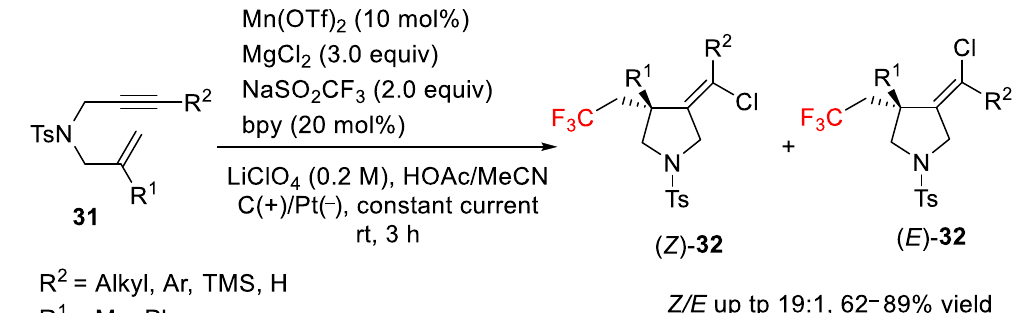
Scheme 25. Electrocatalytic synthesis of pyrrolidine